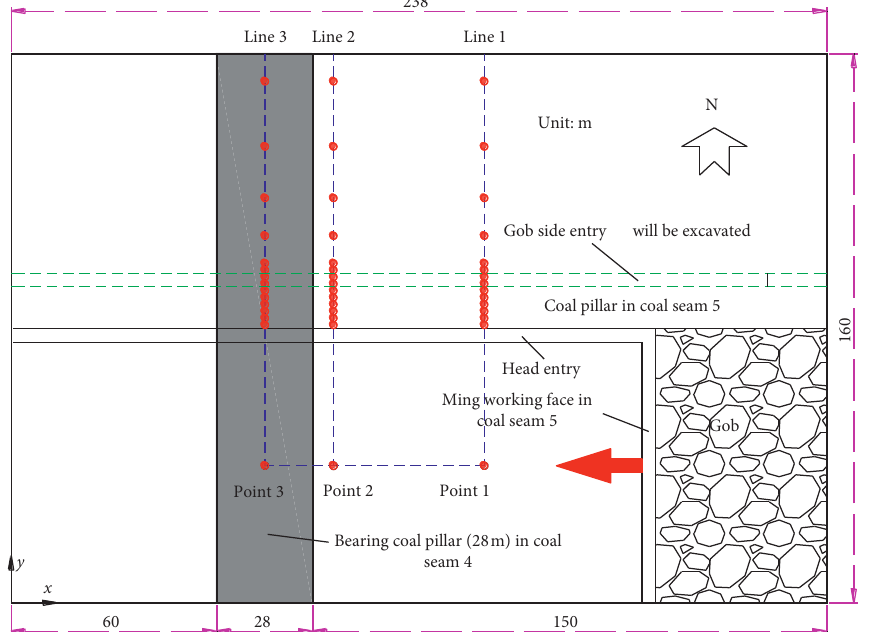
Figure 4: Monitoring scheme during the simulation step 4.